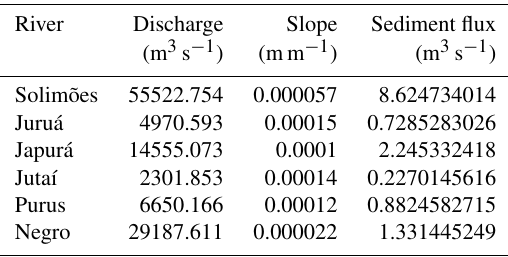
Table 2. Current discharge, slope and sediment flux of the rivers outside of the grid. The sediment flux was calculated using the Eq. (1) and the parameters in Table